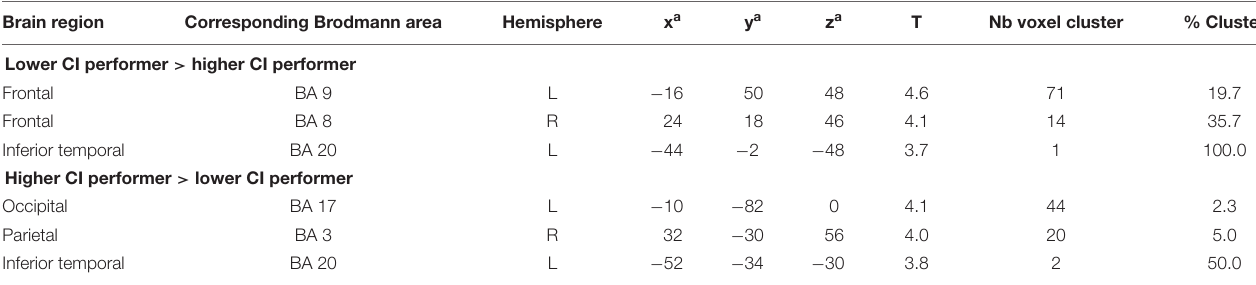
TABLE 3 | Results of unpaired t -tests comparing the difference images (speech condition - rest condition) between CI users with lower and higher speech comprehension (significance level used for inferences at a voxel level p < 0.001, extent voxel threshold k = 0). Brain